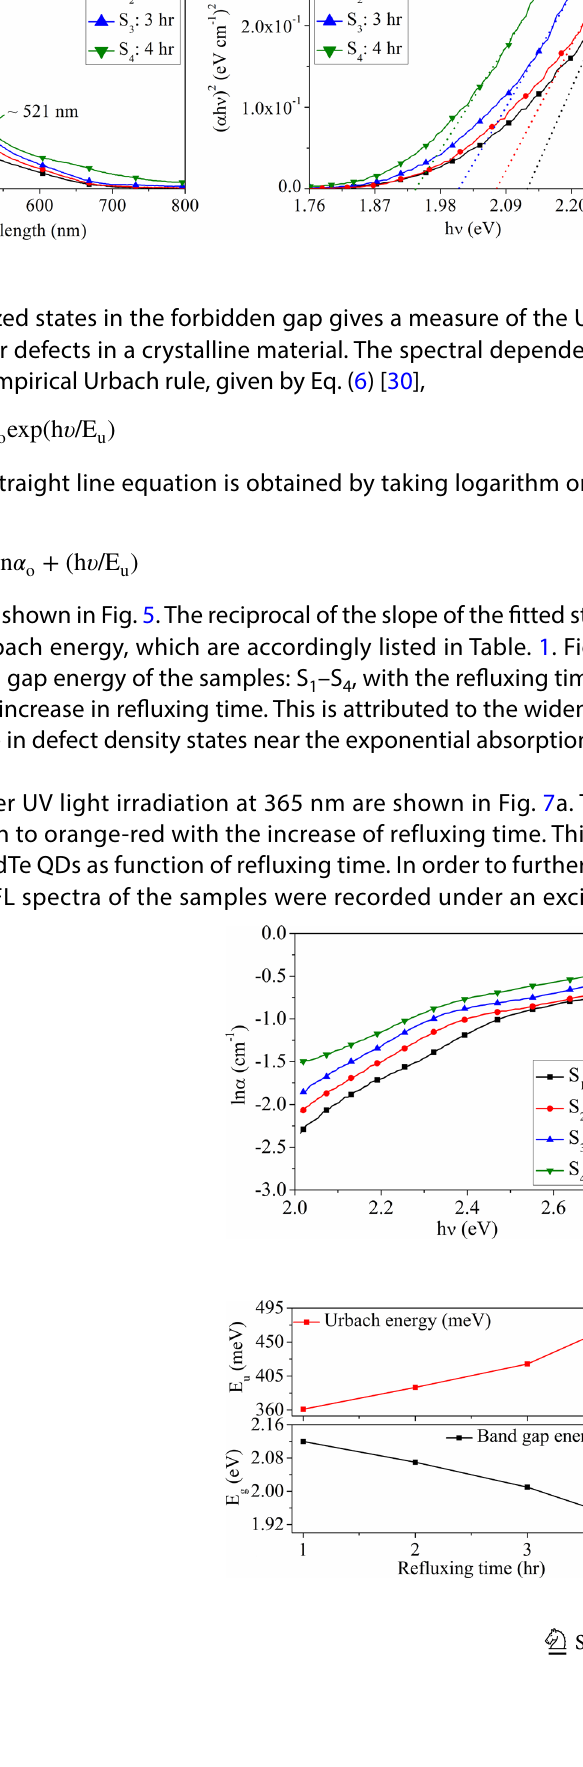
Fig. 4 a UV–Visible absorption spectra and b plot of (αhυ) 2 versus hυ of CdTe QDs for the samples: S –S , respectively. 1 4